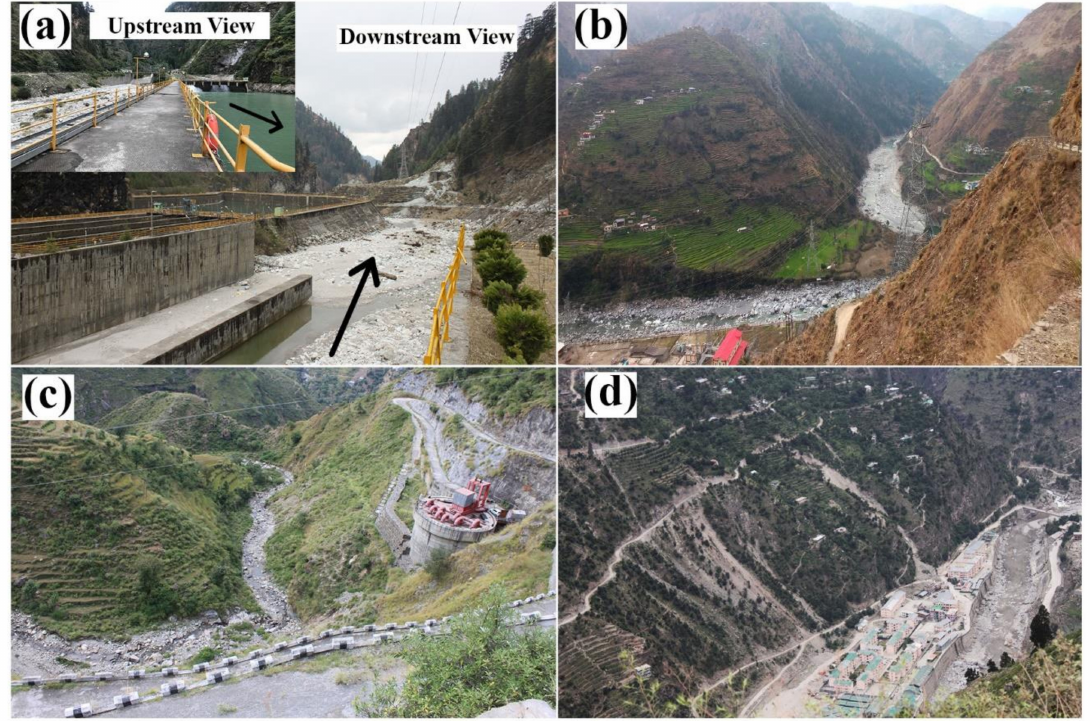
Figure 2. Dry river channel after stream water diverted / blocked for hydropower purposes at ( a ) Parbati sub-basin of Beas basin of Kullu districts ( b , c ) Ravi basin of Chamba districts, ( d ) Satluj basin of Kinnaur districts. All the photographs were taken during our primary